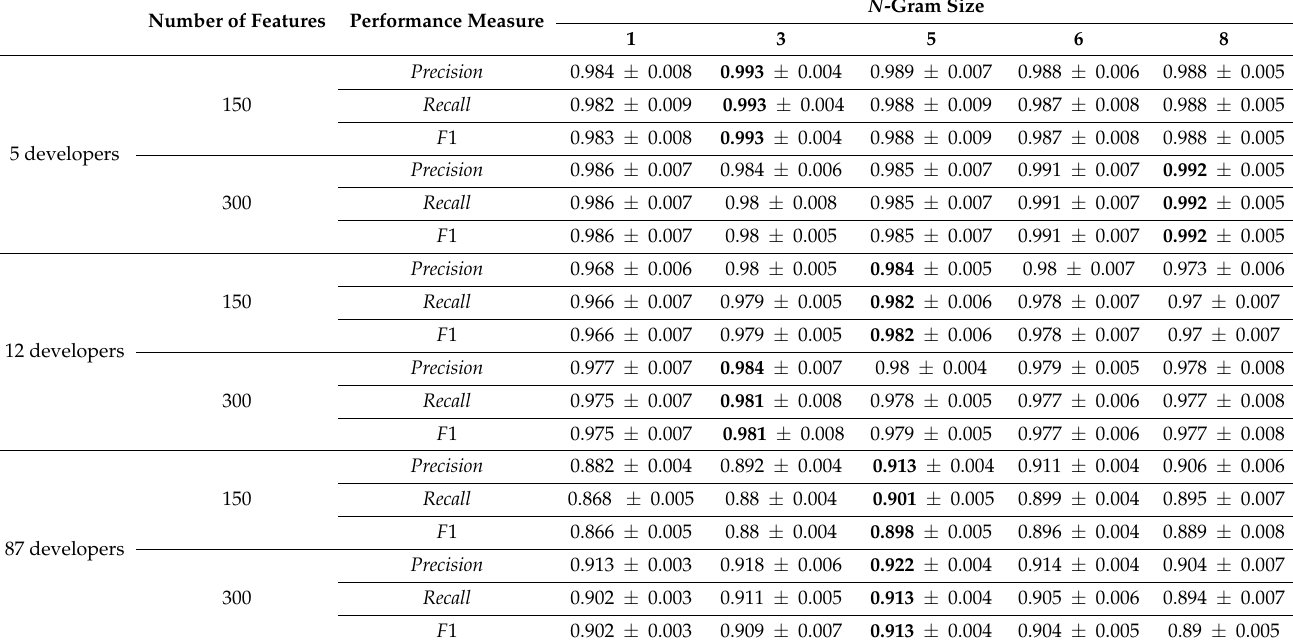
Table 2. AutoSoft results with respect to N -gram size for subsets of 5, 12 and 87 developers. In addition, 95% confidence intervals are used for the